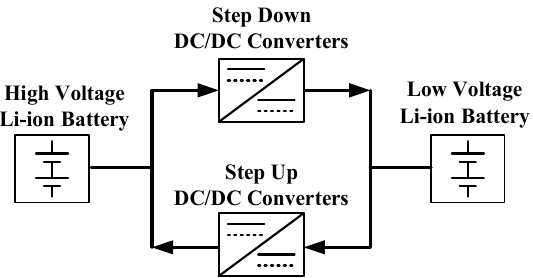
Figure 1. Circuit blocks of conventional bidirectional converter.